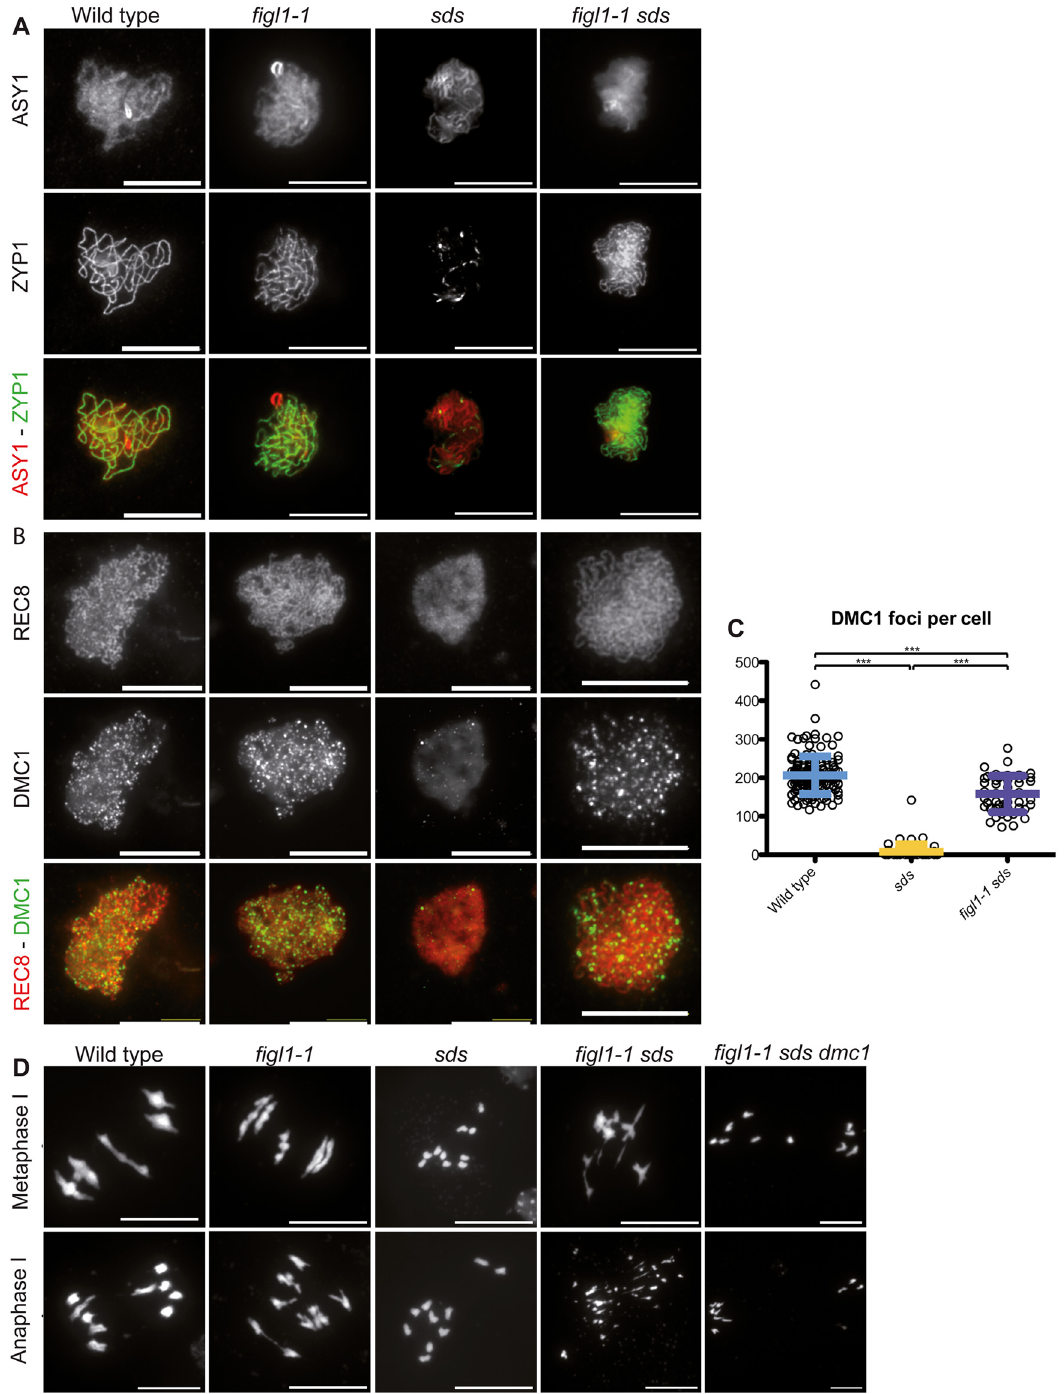
Fig 6. FIGL1 genetically interacts with SDS . A: ZYP1 immuno-localization as a marker of synapsis, with the chromosome axis protein ASY1 used as a counterstain, showing that synapsis is restored in figl1-1 sds double mutant compared to sds single mutant. B: DMC1 immuno-localization with the REC8 cohesin used as a counterstain showing that DMC1 foci formation is restored in figl1-1 sds compared to sds . C: Quantification. D: DAPI staining of meiotic chromosome spreads at metaphase I (top) and anaphase I (bottom). While sds mutant meiosis displays 10 univalents, figl1-1 sds meiosis presents bivalent like structures at metaphase I and chromosome fragments at anaphase I, indicative of unrepaired recombination intermediates. Bivalent and fragmentation are not observed in figl1-1 sds dmc1